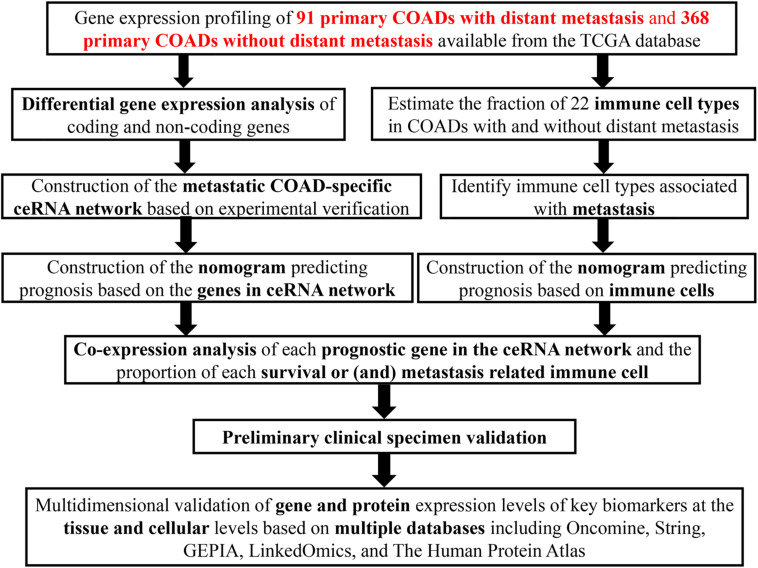
The flow chart of the whole research process.